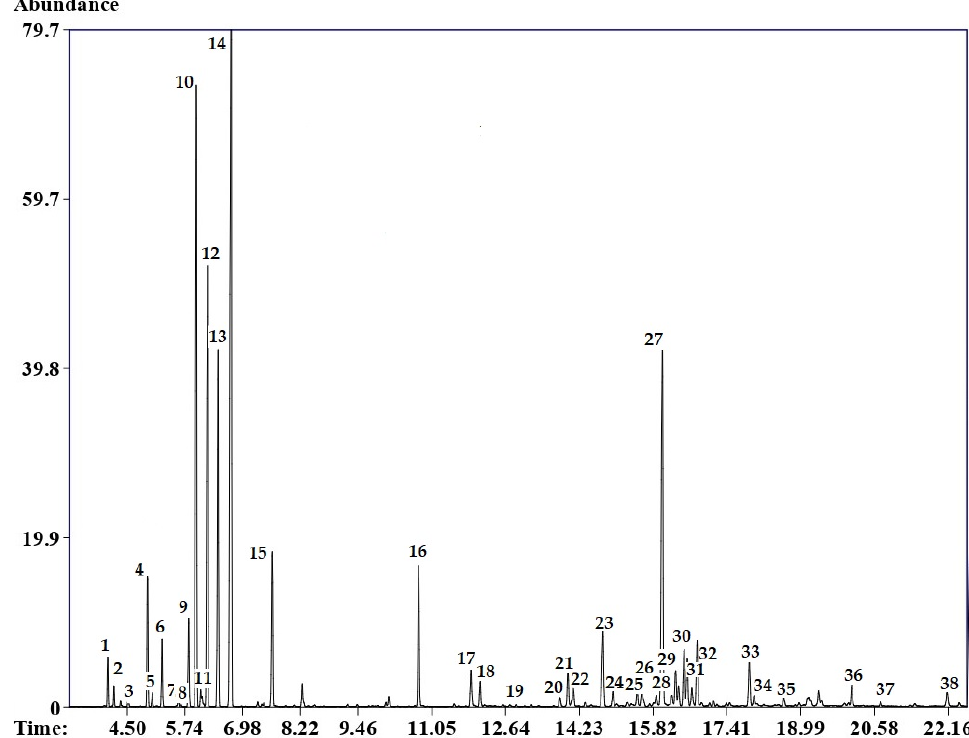
Figure 1. Gas chromatogram of OEO from western Romania. Table 2. Chemical composition of OEO as determined by GC ‐ MS analysis.